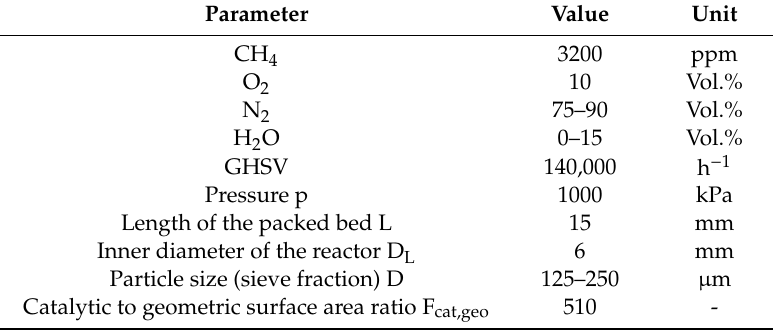
Table 2. Summary of the experimental parameters and model input.